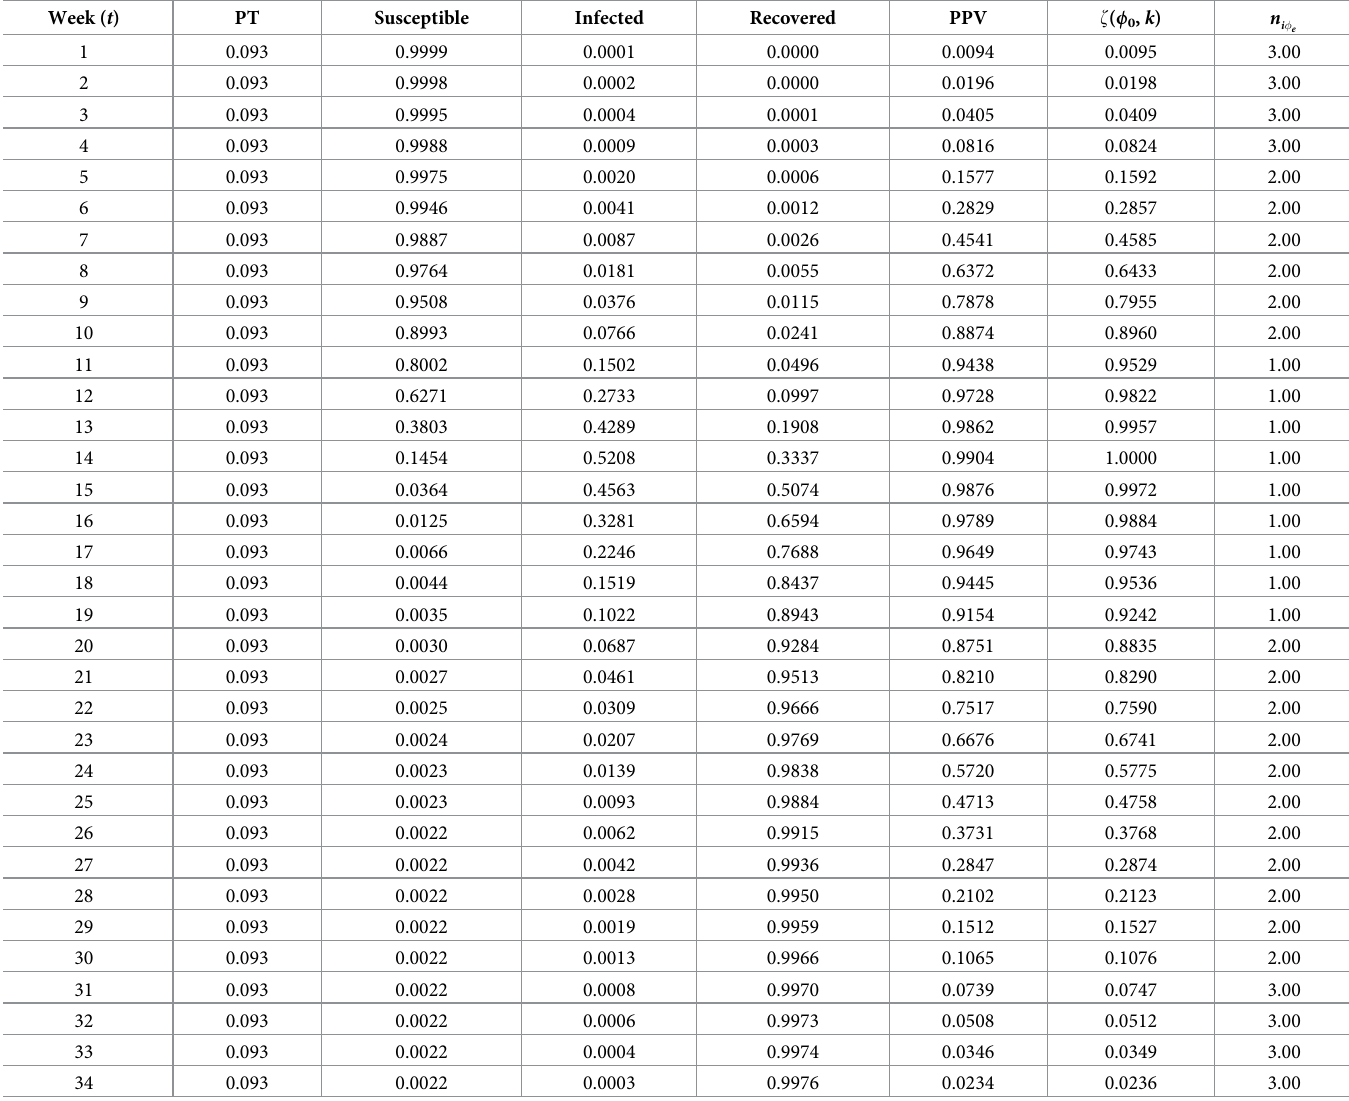
Table 1. Numerical representation of the SIR